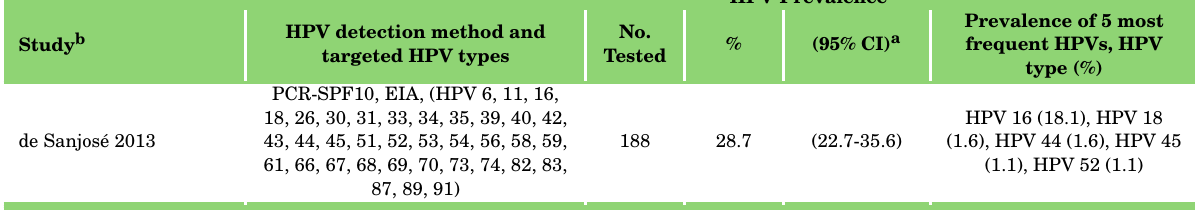
Table 27: Studies on HPV prevalence among vulvar cancer cases in India